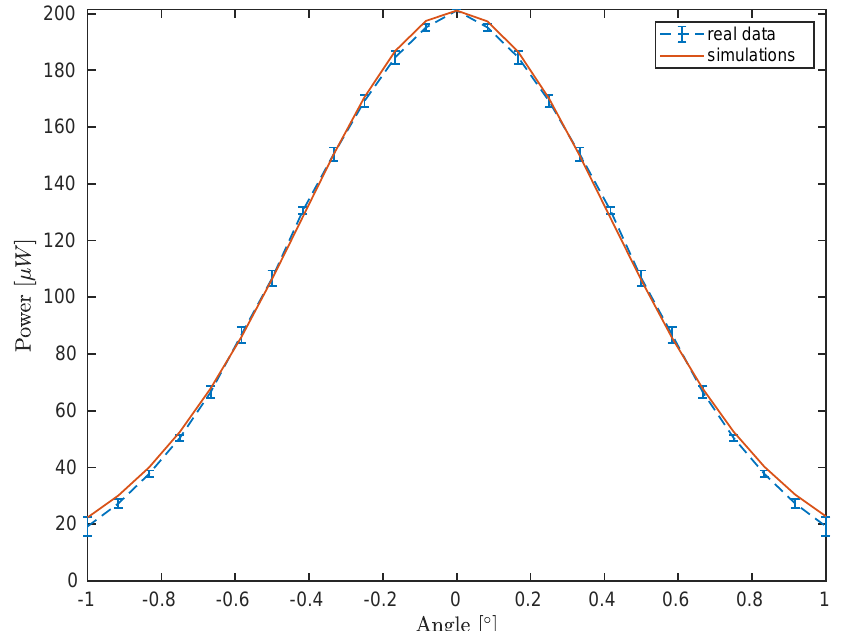
Figure 8. Angular scattering profile of a coverglass: comparing experimental data (blue dashed line) with simulations